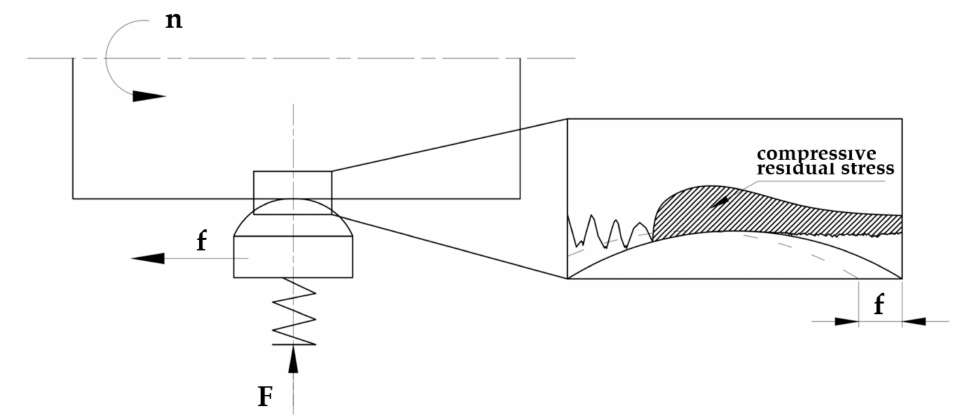
Figure 1. Schematic diagram of sliding friction burnishing (F—burnishing force; n—revolution; f—feed